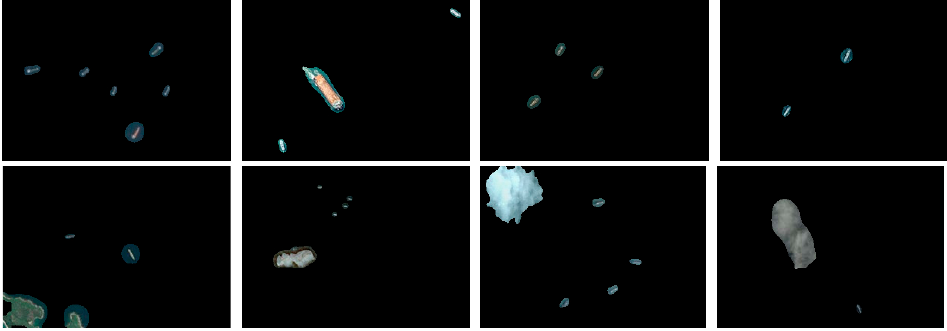
Figure 7. Ship target region extraction and marking.